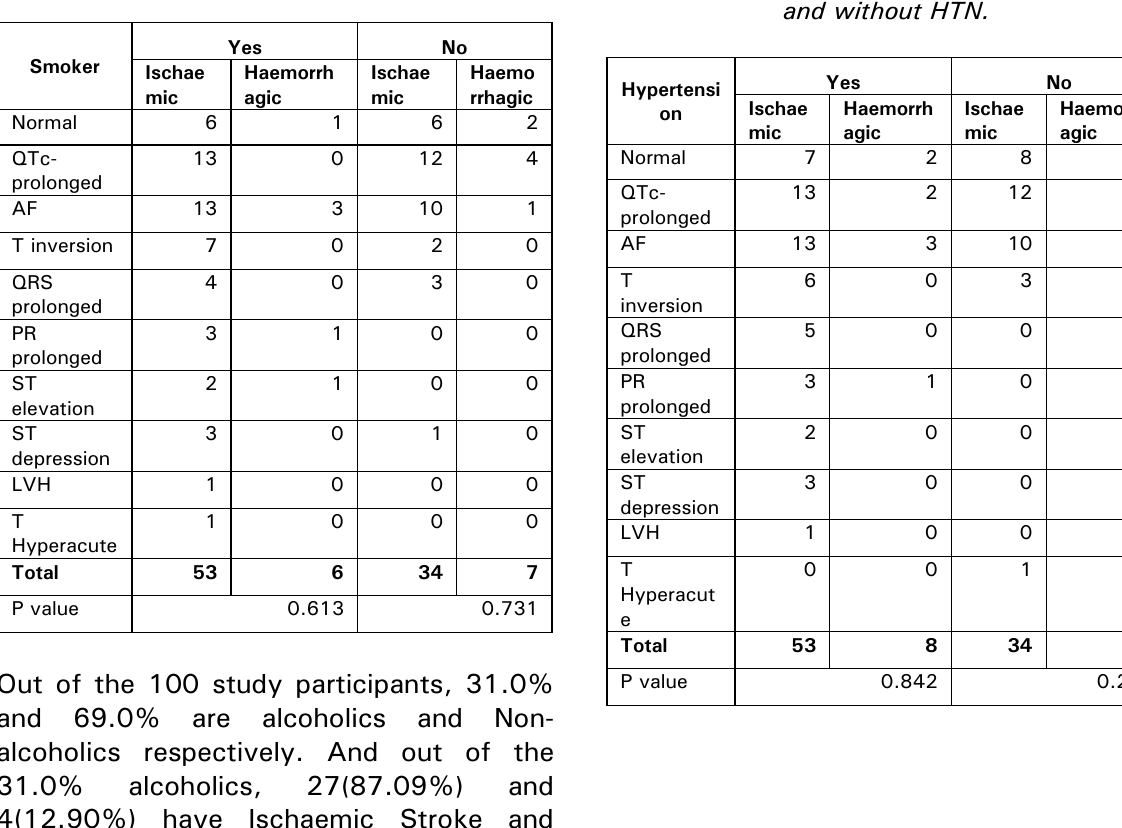
Table 3: Comparison of ECG changes in Ischaemic and Haemorrhagic Stroke on the basis of Smoking. Table 4: Comparison of ECG changes in